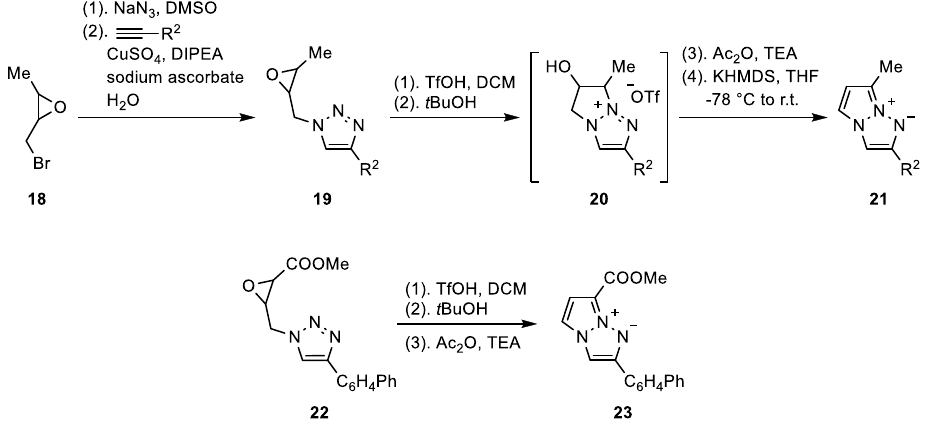
Table 6. Fluorescence properties and reaction yields of selected 2-substituted 6-methyl-TAPs 21a–e in DCM.